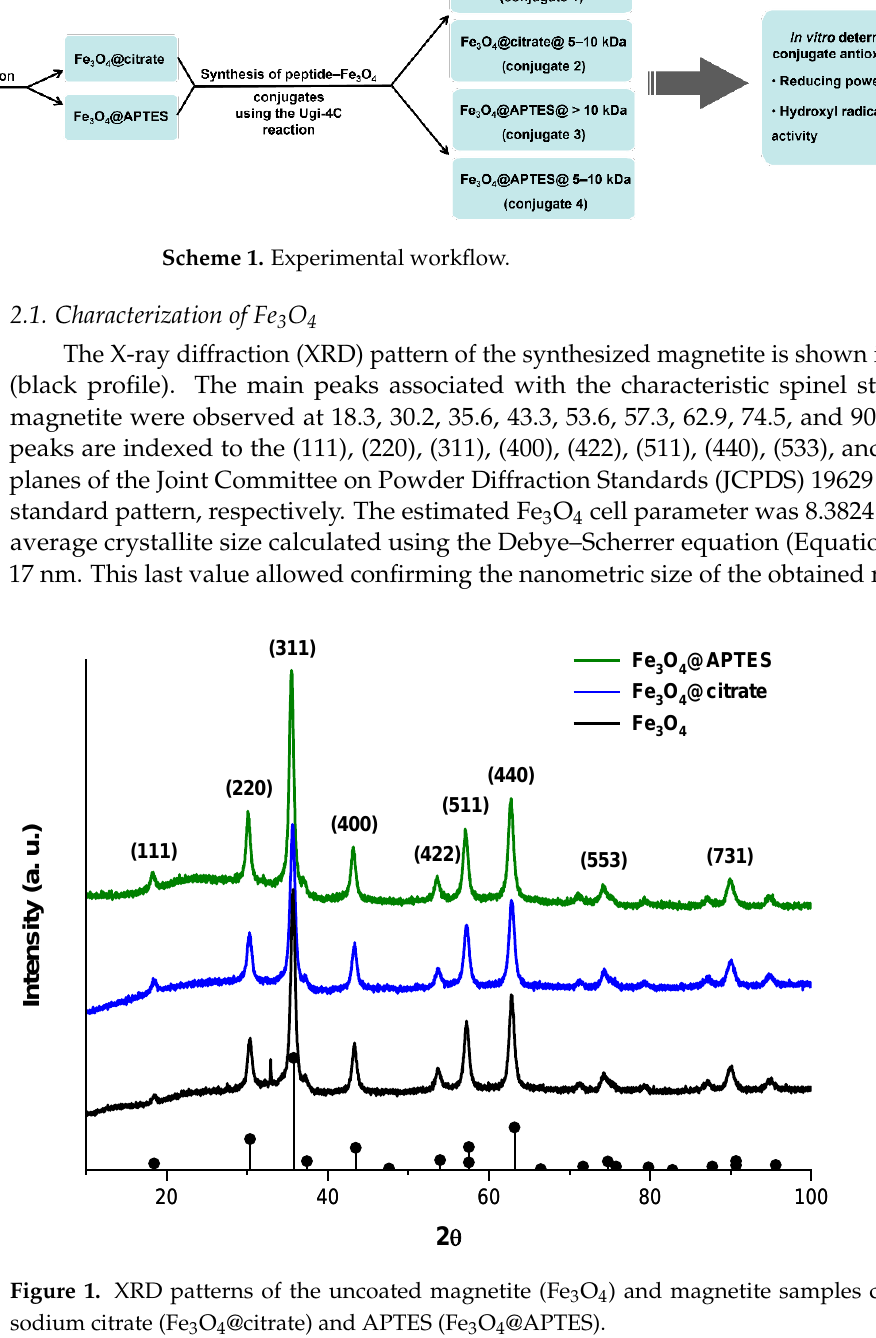
Figure 1. XRD patterns of the uncoated magnetite (Fe 3 O 4 ) and magnetite samples coated with sodium citrate (Fe 3 O 4 @citrate) and APTES (Fe 3 O 4 @APTES).